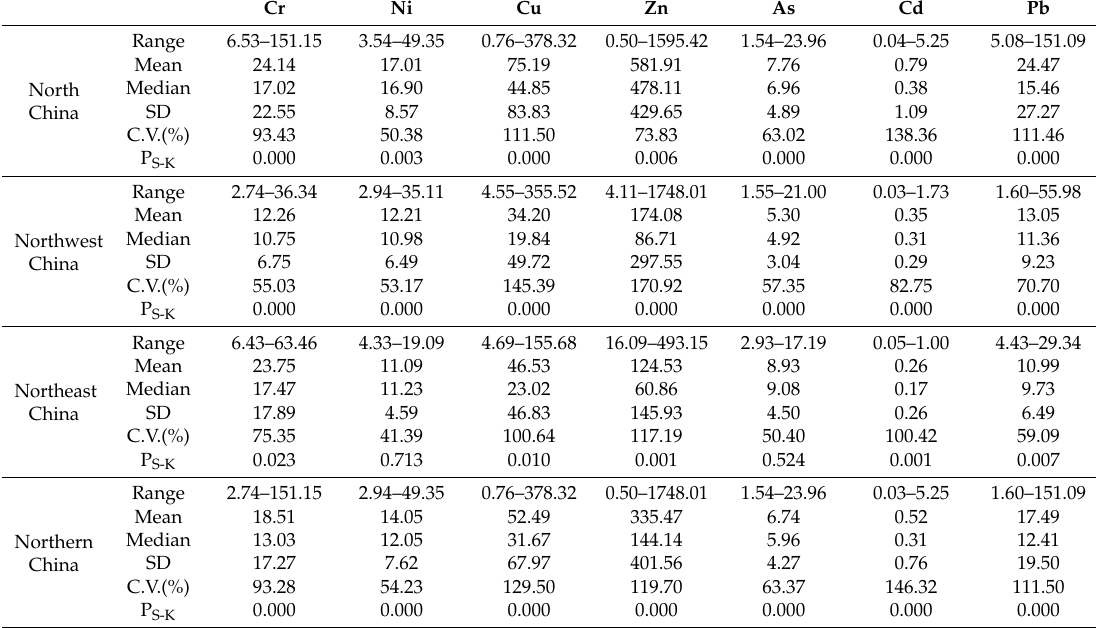
Table 4. Trace metal concentrations in organic fertilizer in northern China (mg · kg − 1